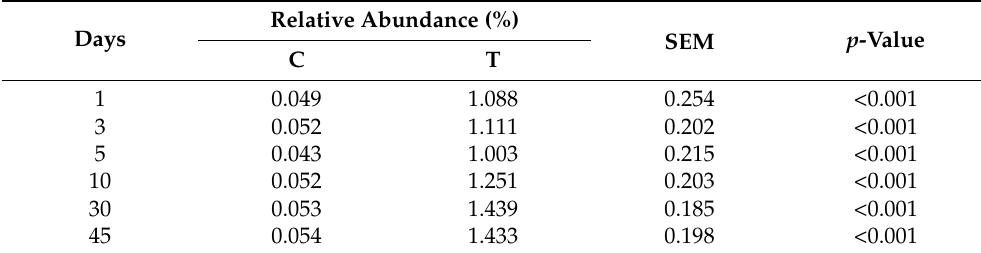
Table 5. Relative abundance of Bacillus during the ensiling process.